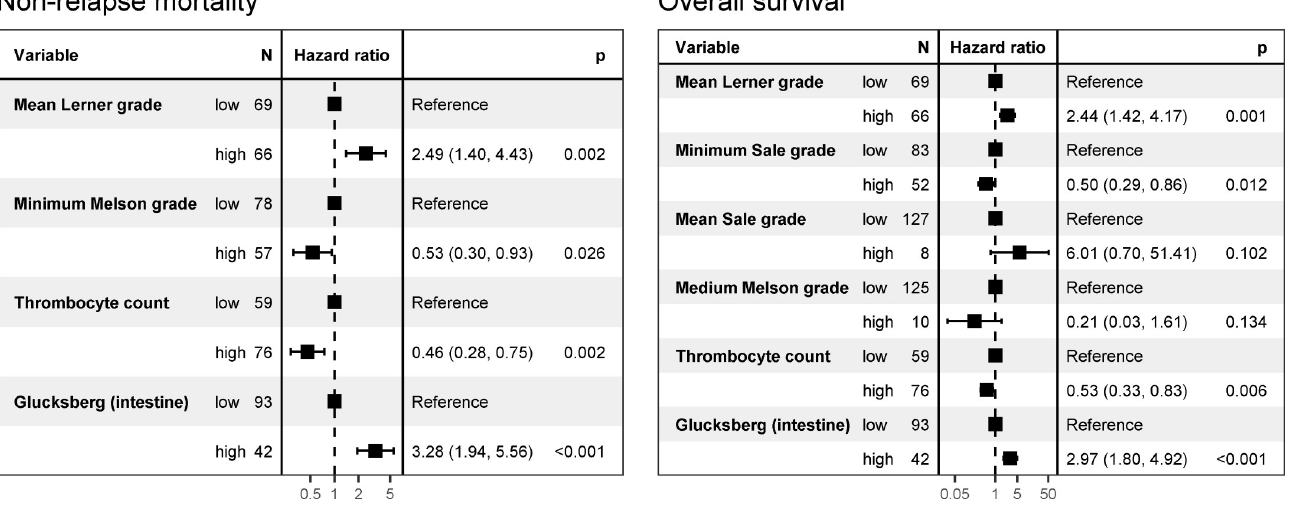
Fig 8. Multivariate Cox regression analysis of non-relapse mortality and overall survival on covariates selected using the Akaike information criterion backward stepwise variable method.